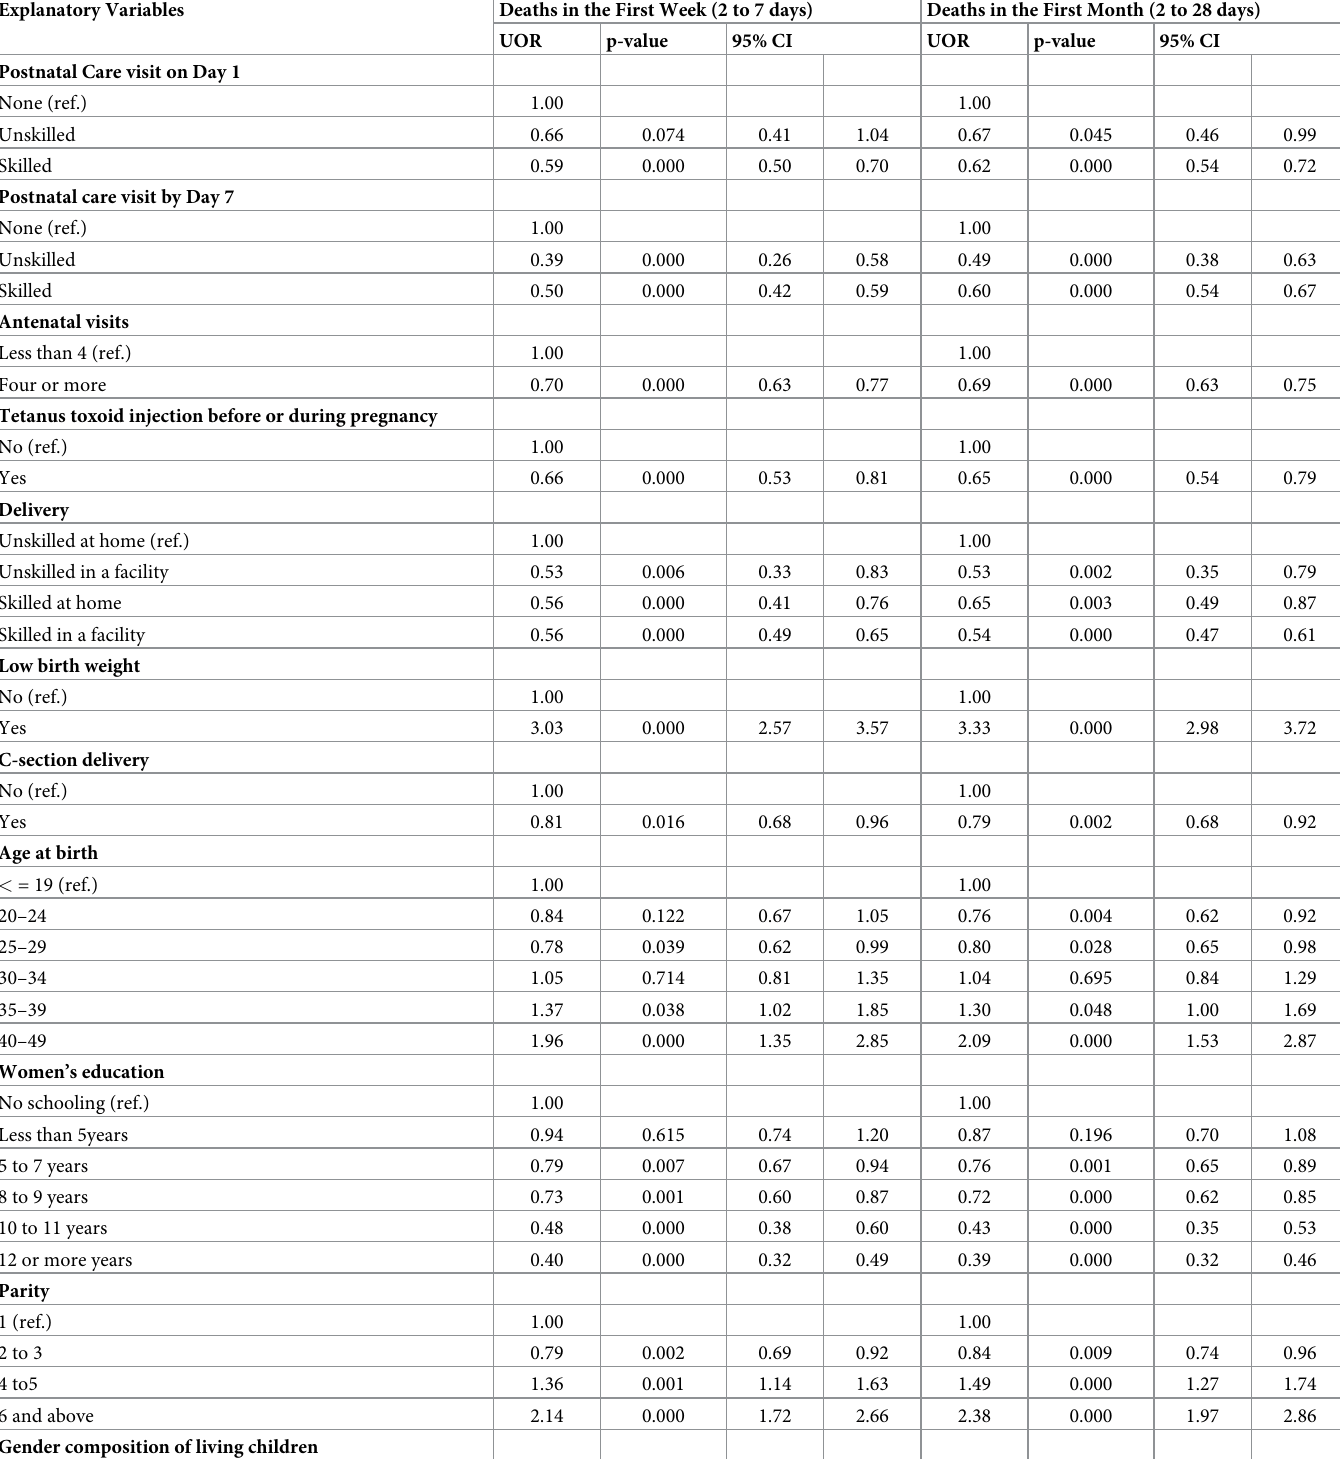
Table 2. Parameter estimates (Unadjusted Odds Ratio (UOR)) for binary weighted logistic regression models of neonate deaths between Days 2 and 7 and deaths between Days 2 and 28 by PNC and other selected background variables, India 2015–16. Explanatory